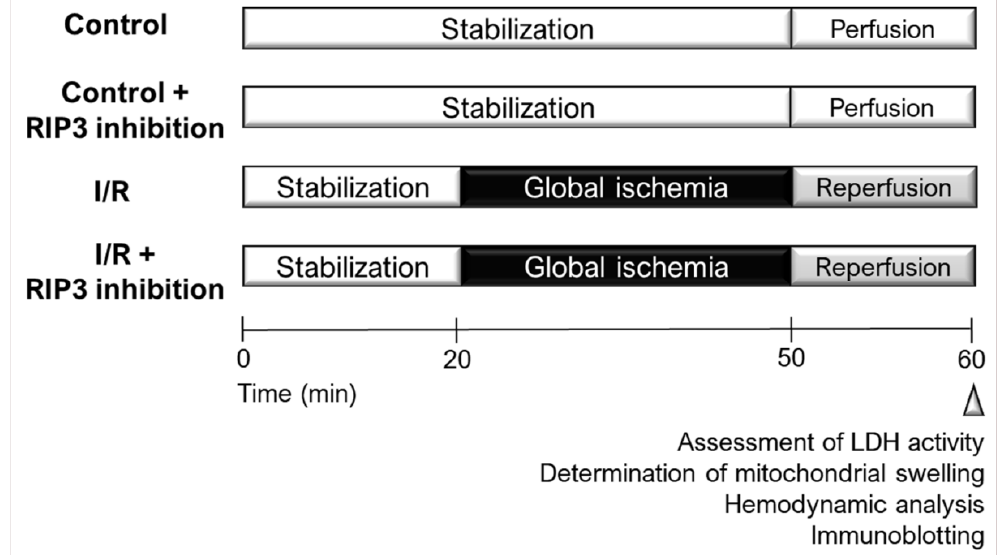
Figure 8. An illustration showing experimental design. RIP3 inhibitors—GSK’872 or HS-1371—were added during the whole 10 min